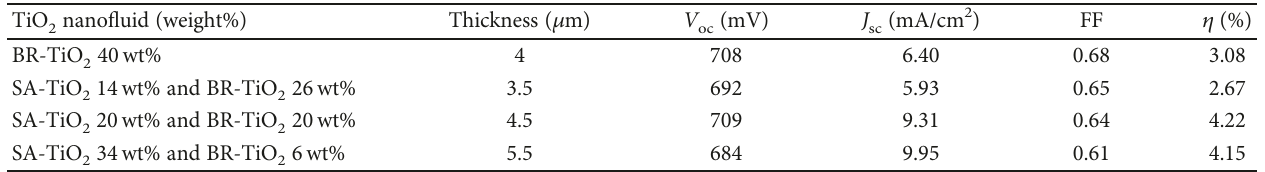
nano fl uids.Two-stepmethodwasusedtomanufacturethesemiconductor 2